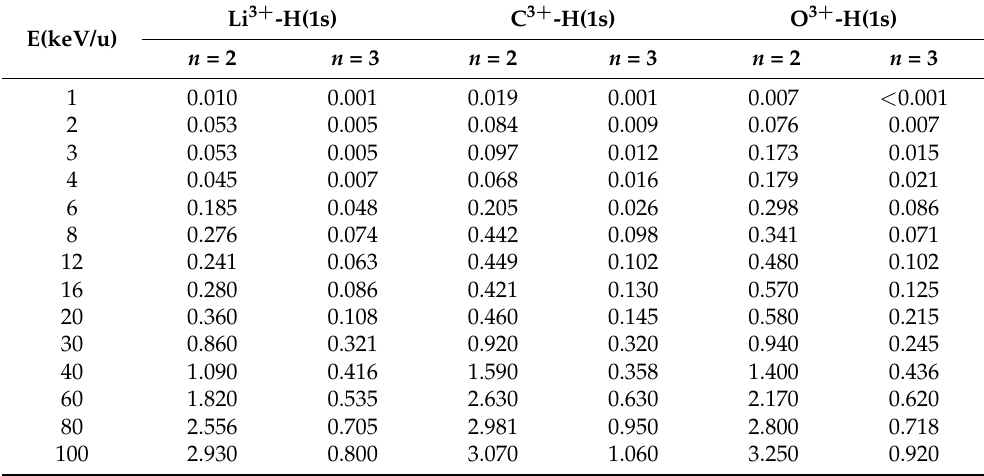
Table A1. n -state selective excitation cross sections (10 − 16 cm 2 ) for Li 3 + , C 3 + , and O 3 + collisions with ground-state hydrogen from 1 to 100 keV/u.